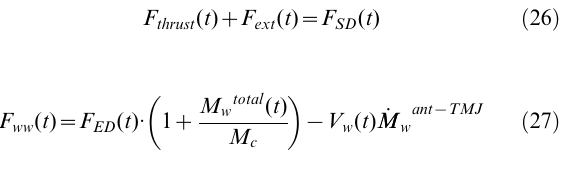
(Figure 1), A c (t) the instantaneous mouth area (equation 11) and A cmax the maximum mouth area (equation 11 with h gapegape =50 u or 78 u ). C Dbody corresponds to the drag coefficient for a